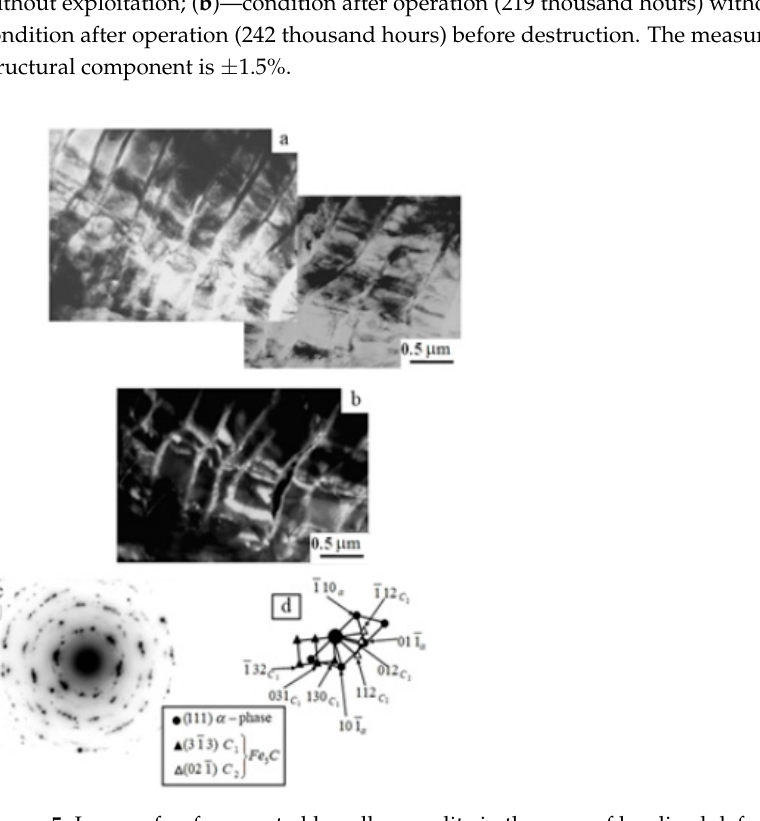
Figure 6. Image of the structure of lamellar pearlite in the zone of localized deformation of an undisturbed specimen of 0.2 С steel (UP—unfragmented, FP—fragmented pearlite). Transmission electron microscopy. The metal matrix of the 0.2 С steel sample after long-term operation and destruction is also the α -phase—a solid solution of carbon and alloying elements in α -Fe with a bcc crystal lattice, as in the samples of the initial state and in the undisturbed sample. Lamellar pearlite and ferrite are also morphological components of the phase. The volume fraction of lamellar pearlite is also 85%, ferrite—15% (Figure 4c).